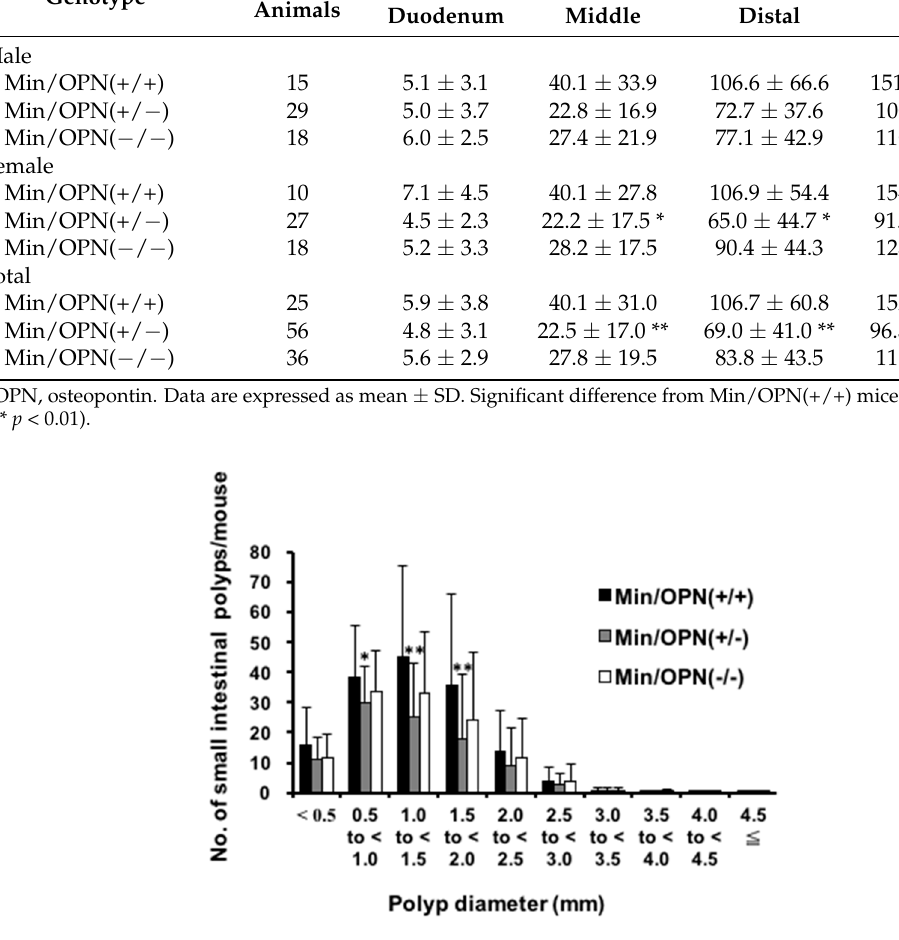
Figure 1. The effect of OPN deficiency on the size distribution of small intestinal polyps in Min mice.